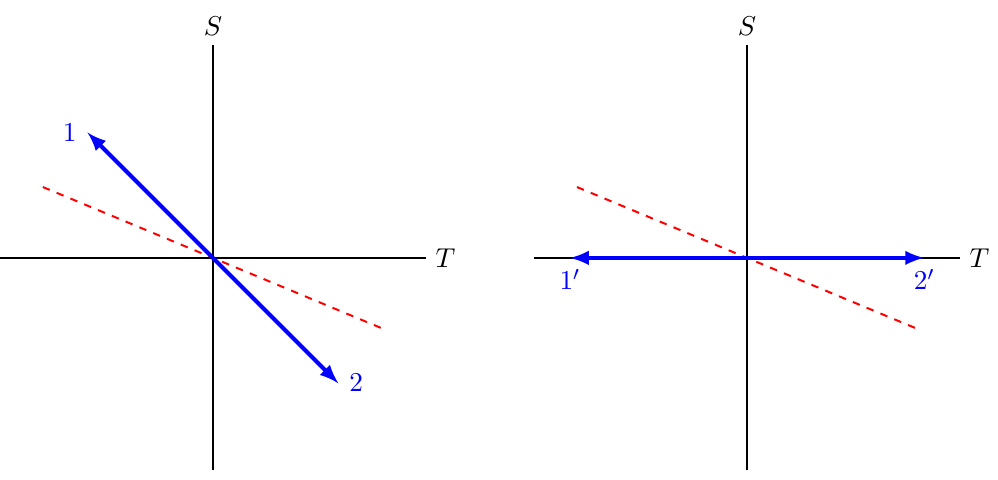
Figure 3. The normal fans of the Newton polytopes S + T (left) and 1 + T 2 (right). The rays are drawn in blue arrows; the cones are {{ 1 } , { 2 }} and {{ 1 0 } , { 2 0 }} respectively. The two fans are isomorphic to each other, by the flip along the same red dashed line as in figure